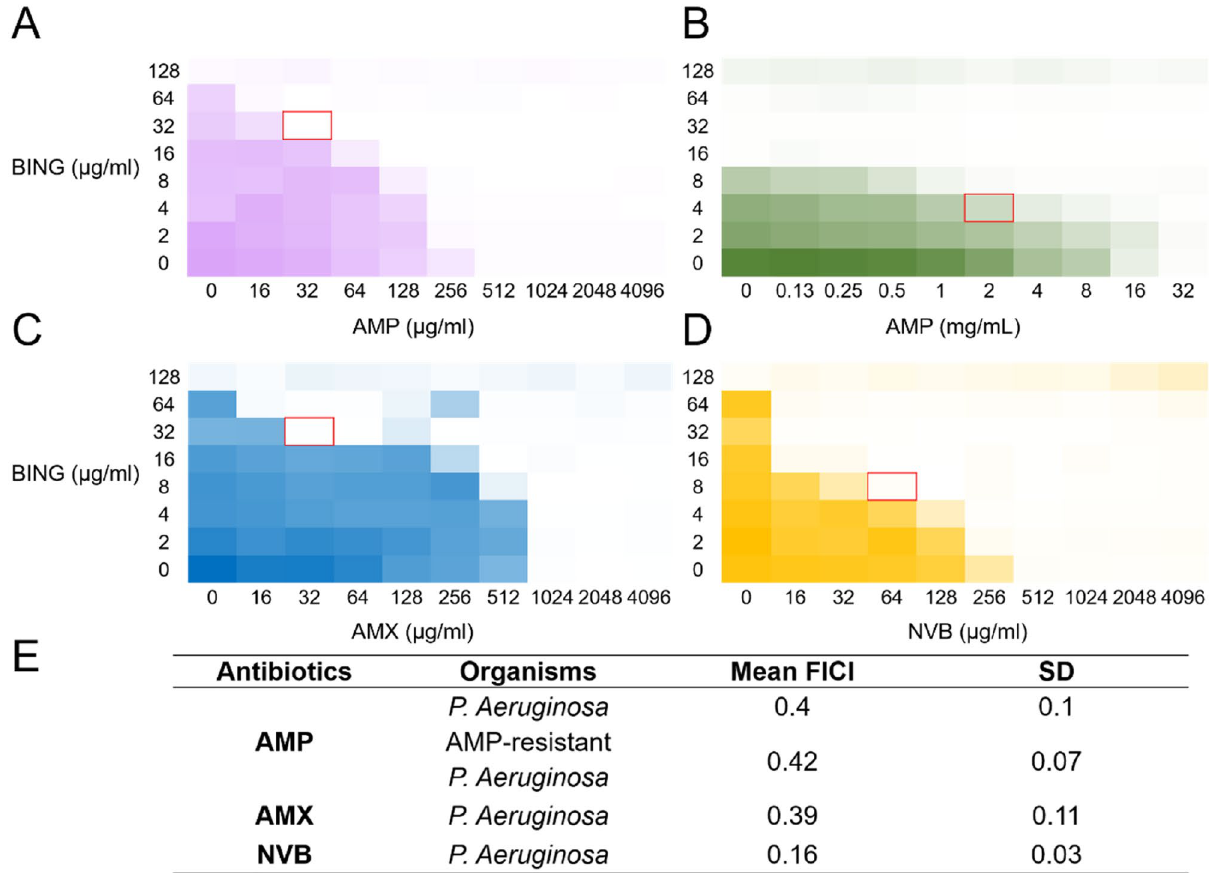
Figure 6. Combinational effect of BING and antibiotics. Checkerboard assay on the growth of ( A ) P. aeruginosa and ( B ) ampicillin-resistant P. aeruginosa treated with BING and Ampicillin. ( C , D ) Checkerboard assay on the growth of P. aeruginosa with BING and Amoxicillin or Novobiocin, respectively. Representative data from three replicates. ( E ) Summary of FICIs of all the checkerboards. AMP ampicillin, AMX amoxicillin, NVB